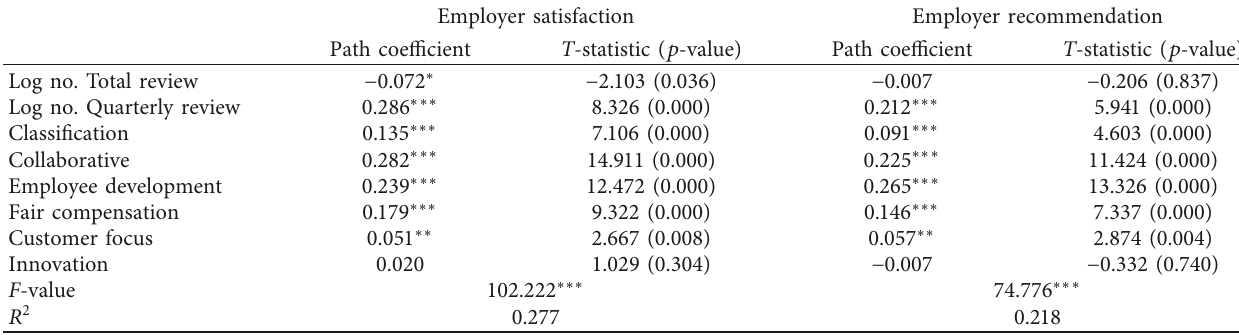
Table 3: Results of regression analysis. Note. ∗∗ p < 0 . 01 , ∗∗∗ p < 0 .